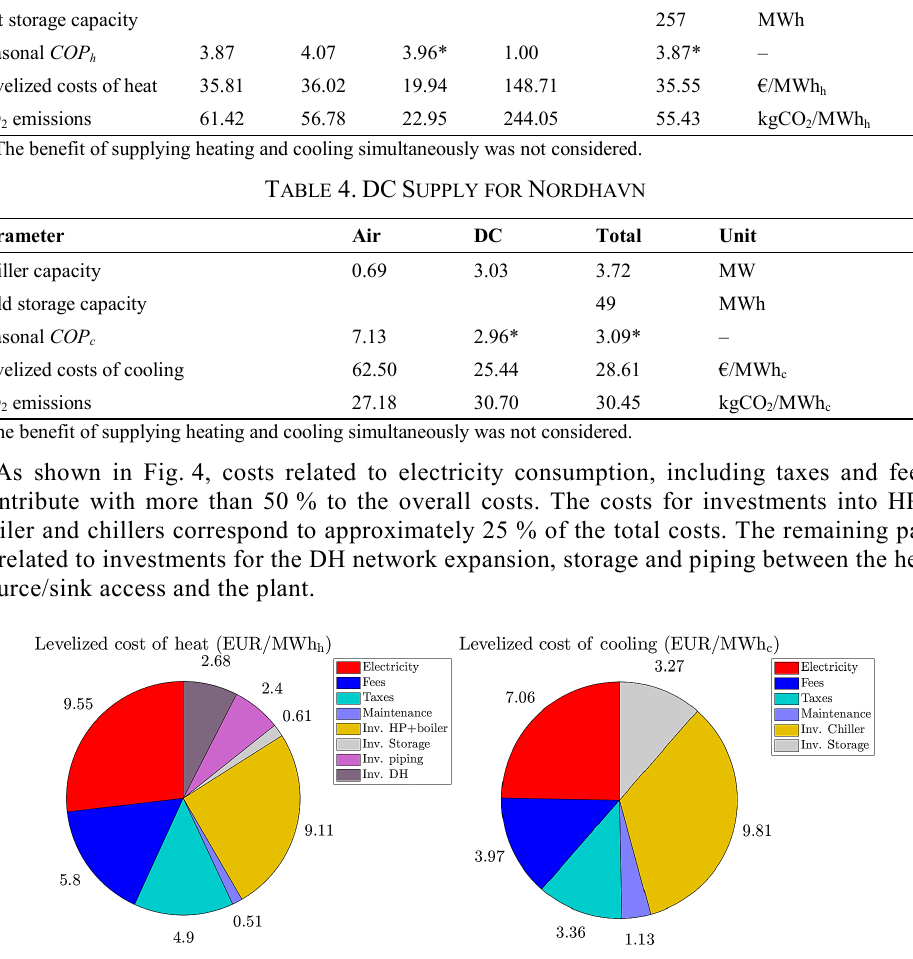
Fig. 4. LCOH and LCOC for the most economical supply of DH and